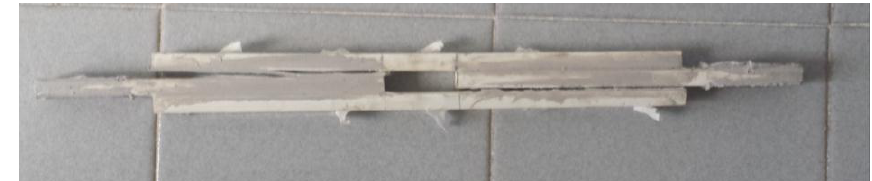
Figure 14. Post-failure configuration—joint sample “I”.